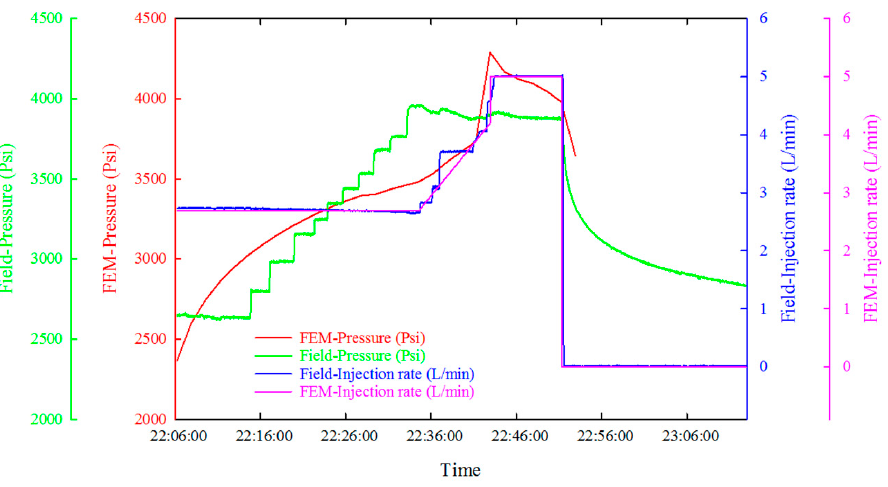
Figure 15. Three connectors are yielded during the injection: ( a ) shows the connector between E1-I and E1-P; ( b ) shows the connector between E1-PDT and E1-PST and the connector between E1-P and E1-PST.